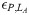
States and weights for a simple activation motif.Binding of RNAP (blue) to a promoter is facilitated by the binding of the activator CRP. Simultaneous binding of RNAP and CRP is facilitated by an interaction energy ϵP,LA for active CRP (dark green) and ϵP,LI for inactive CRP (light green). cAMP (not drawn) influences the concentration of active and inactive CRP as shown in Fig 4.